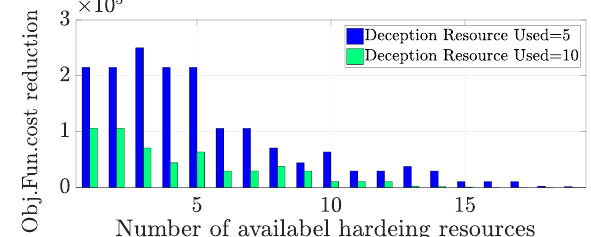
Figure 9. Value of deception verification.